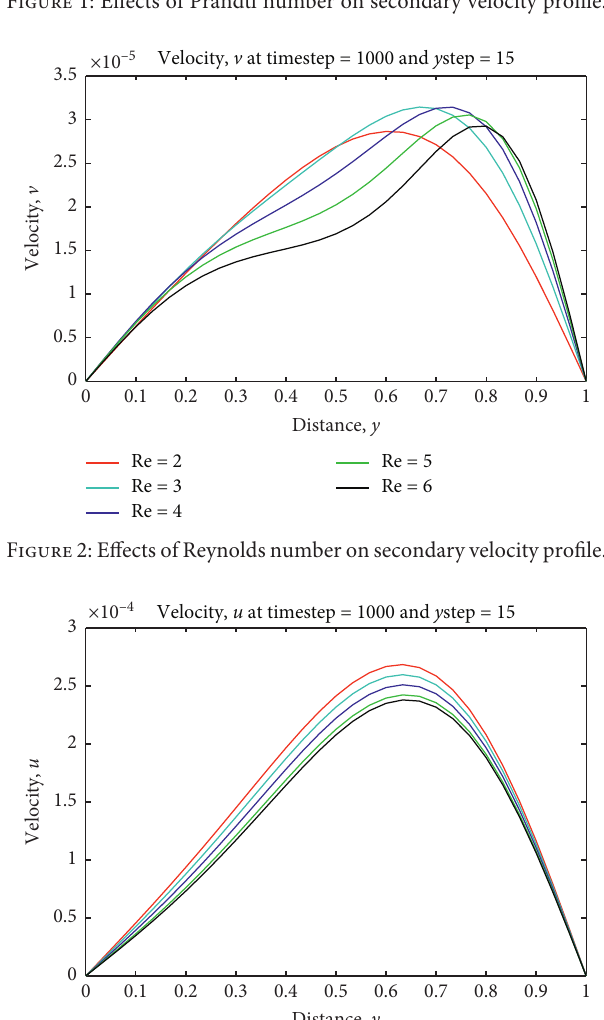
Figure 1: Effects of Prandtl number on secondary velocity profile.